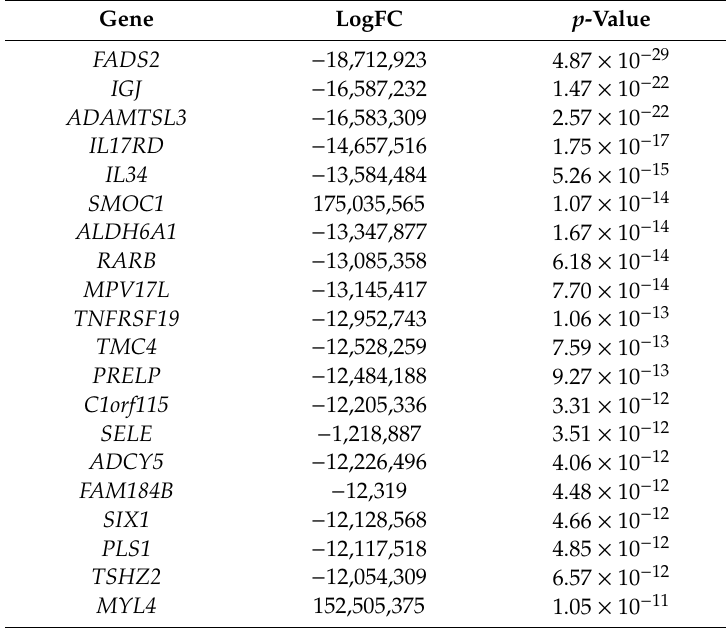
Table 1. 20 most relevant di ff erentially expressed genes (DEGs) exclusively in oral cavity tumour samples compared with normal tissue.